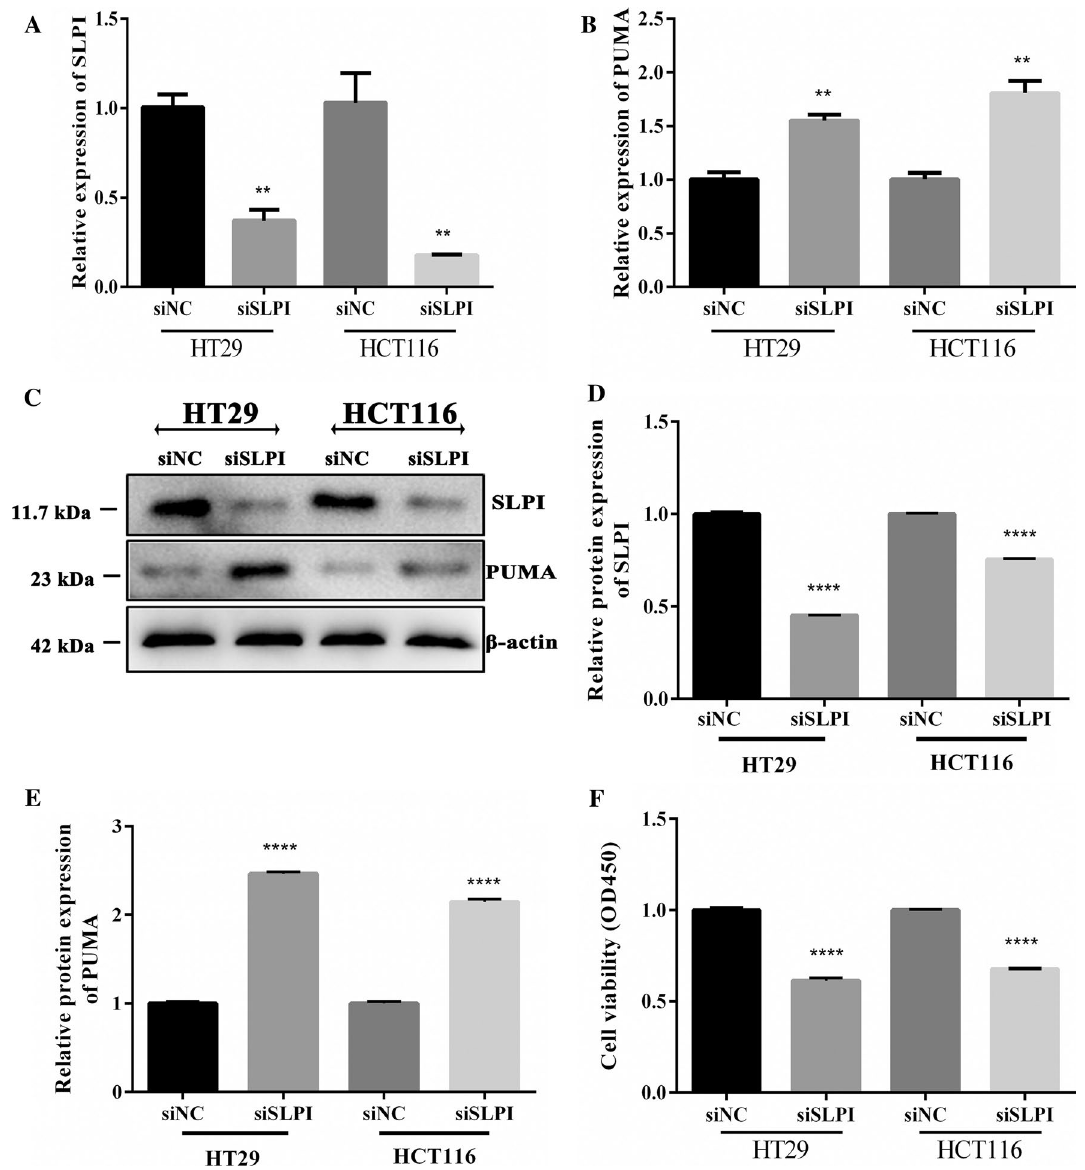
proliferation experiment showed that siSLPI significantly reduced the viability of both HT29 and HCT116 cells ( F ). *p < 0.05; ***p < 0.1, and ****p <